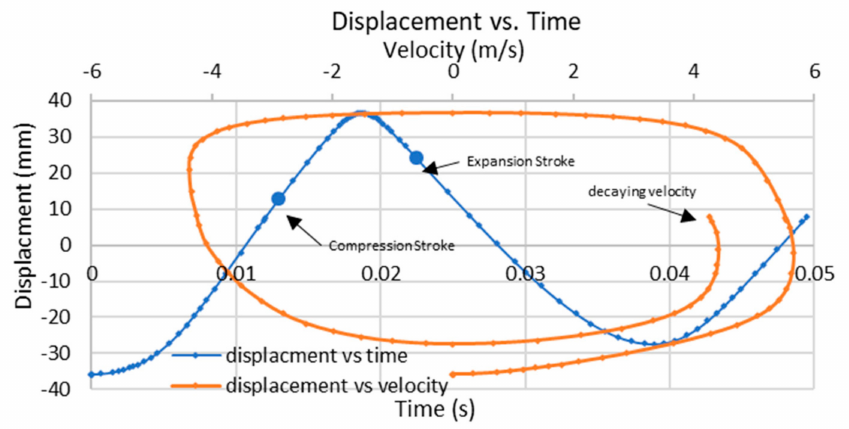
Figure 3. Shorter BC displacement endpoint with larger BC piston area, and piston assembly hi-ting BC cylinder head for large CC combustion pressure of two-stroke FPLG.